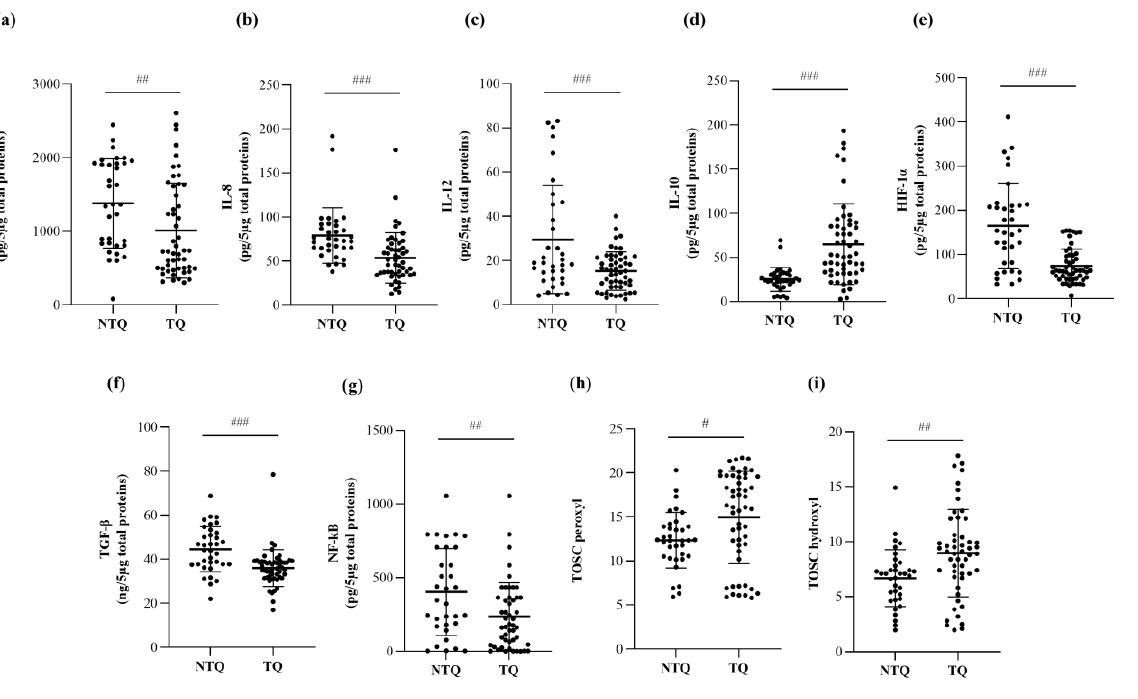
Figure 2. Protein levels of the proinflammatory cytokines IL-6 ( a ), IL-8 ( b ), and IL-12 ( c ); the anti- inflammatory cytokine IL-10 ( d ); the pro-inflammatory factors HIF-1 α ( e ), TGF- β ( f ), and NF-kB ( g ); and TOSC values against peroxyl ( h ) and hydroxyl ( i ) radicals in follicular fluid (FF) samples from poor-quality (NTQ) and top-quality (TQ) embryos. The interleukins and pro-inflammatory factors were measured with commercial ELISA kits, while the antioxidant activity (TOSC vs. peroxyl and hydroxyl radicals) of FF samples was measured by chromatographic analysis. The data are reported as the mean values ± SD. Statistical analysis was performed by unpaired t -tests: # p < 0.05, ## p < 0.01, ### p < 0.001 (TQ vs.